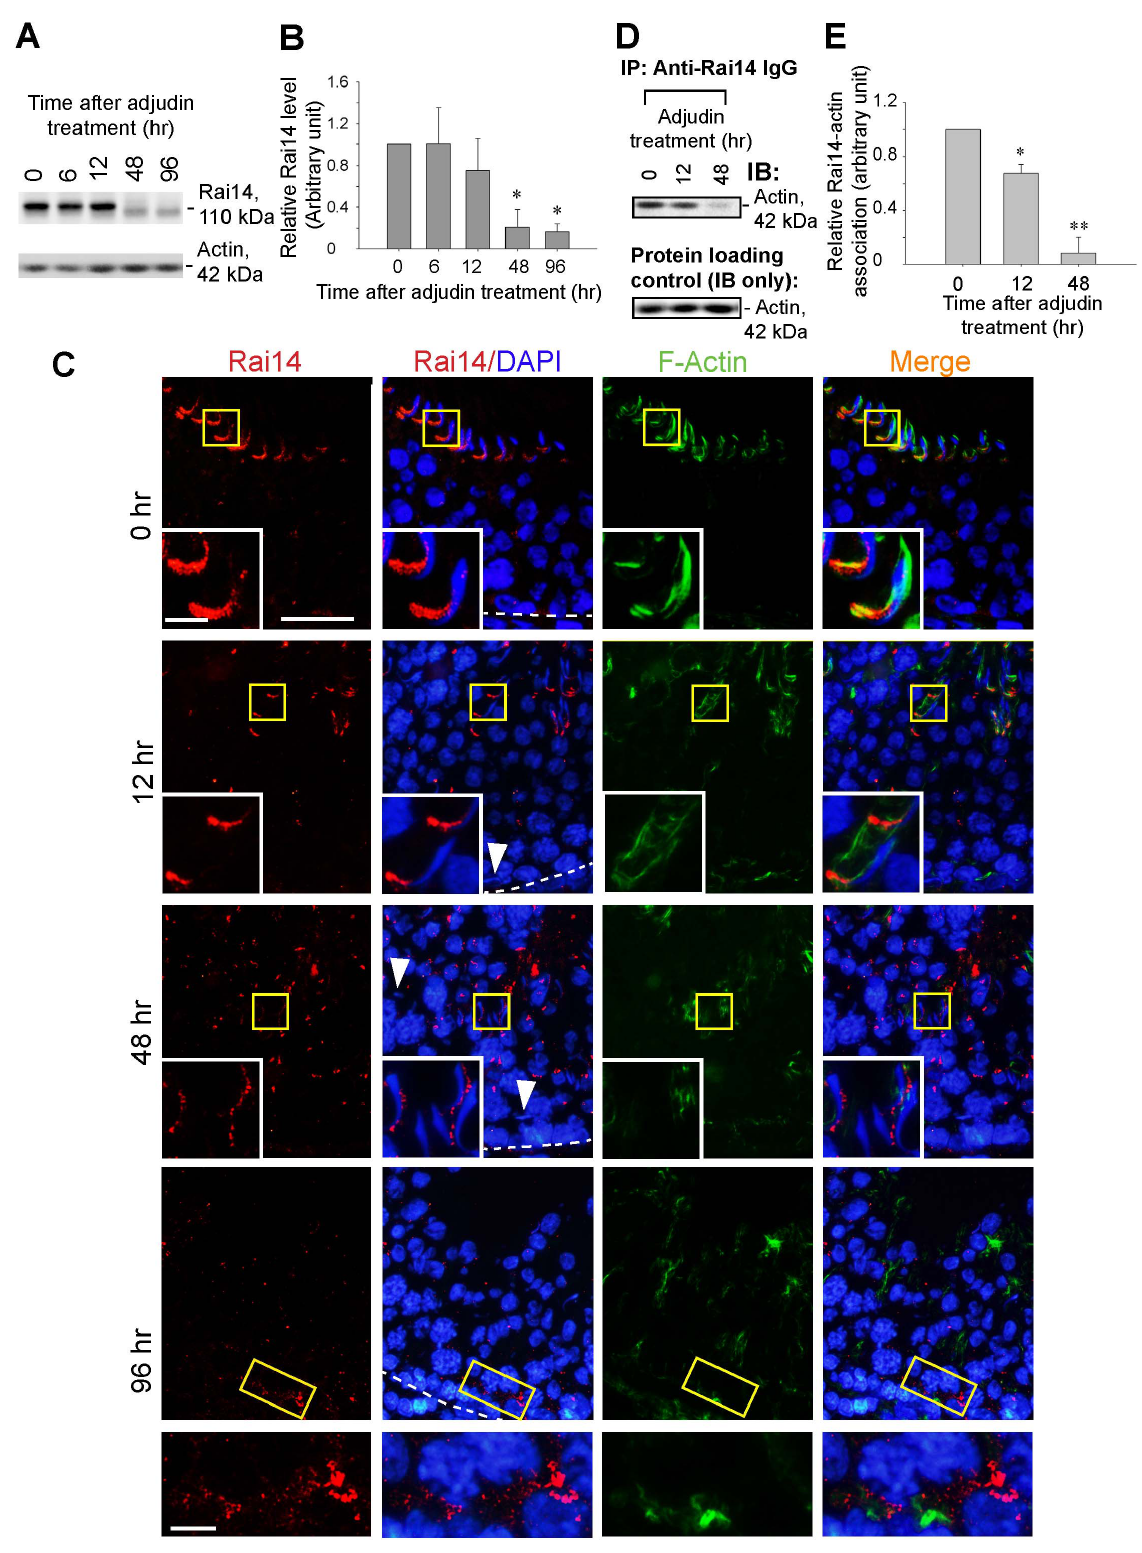
Figure 4. Down-regulation in the expression of Rai14 and a loss of association between Rai14 and F-actin during adjudin-induced apical ES disruption and spermatid loss from the seminiferous epithelium. Adult rats were treated with a single dose of adjudin (50 mg/kg b.w., by gavage) which is known to induce spermatid loss from the seminiferous epithelium since the apical ES, in particular the actin filament bundles at the site, is one of the primary targets of adjudin [7,24]. Rats ( n =3 rats per time point) at specified time points were terminated and used for immunoblotting (A) which illustrated a rapid down-regulation of Rai14 expression following adjudin treatment, and the histogram shown in (B)